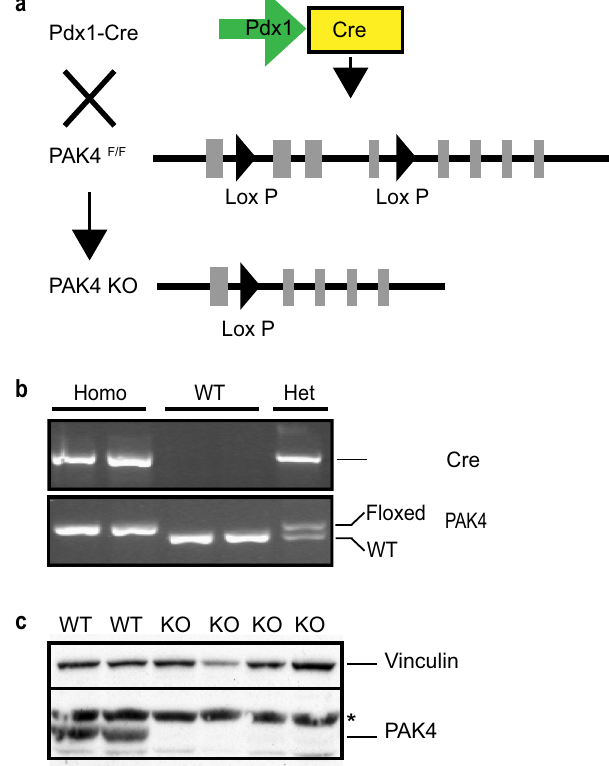
Figure 1. Generation of a mouse model for conditional PAK4 gene depletion in the pancreas. ( a ) Graphical representation of our strategy for generation of a mouse model with conditional PAK4 gene depletion in the pancreas. Exons are indicated by light grey rectangles and Lox P sites are indicated by black triangles. Pdx1- driven Cre expression and consequent recombination of LoxP sites results in the depletion of exons 2–4 in the mouse PAK4 gene as previously described 26 . ( b ) PCR analysis of genomic DNA from 12 days old mouse tails. Upper panel shows the presence of the Pdx1-Cre allele and the lower panel shows PAK4; the upper band in the lower panel displays the floxed PAK4 allele, while the lower band in the lower panel displays a PAK4 WT allele. Thus, appearance of the upper band alone displays homozygous floxed PAK4 allele; the lower band alone represents WT PAK4 allele; while both bands together mean that the mouse is PAK4 heterozygous, i.e. one WT and one floxed allele. Full gels are showed in supplementary Fig. S1a and S1b. ( c ) PAK4 deletion in the mouse pancreas. Immunoblot analysis of pancreatic whole cell lysates shows PAK4 expression in WT pancreas, whereas PAK4 protein expression is below the detection limit in PAK4 homozygous KO mice. Vinculin was used as a loading control. * Shows unspecific bands. Full blot is showed in supplementary Fig.